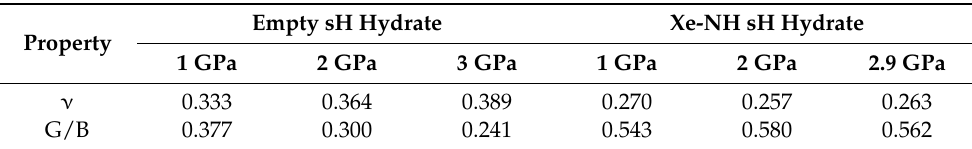
Table 5. Poisson’s ratio ( ν ) and shear to bulk moduli ratio (G/B) of empty and Xe-NH sH gas hydrates under pressure and at 0 K.